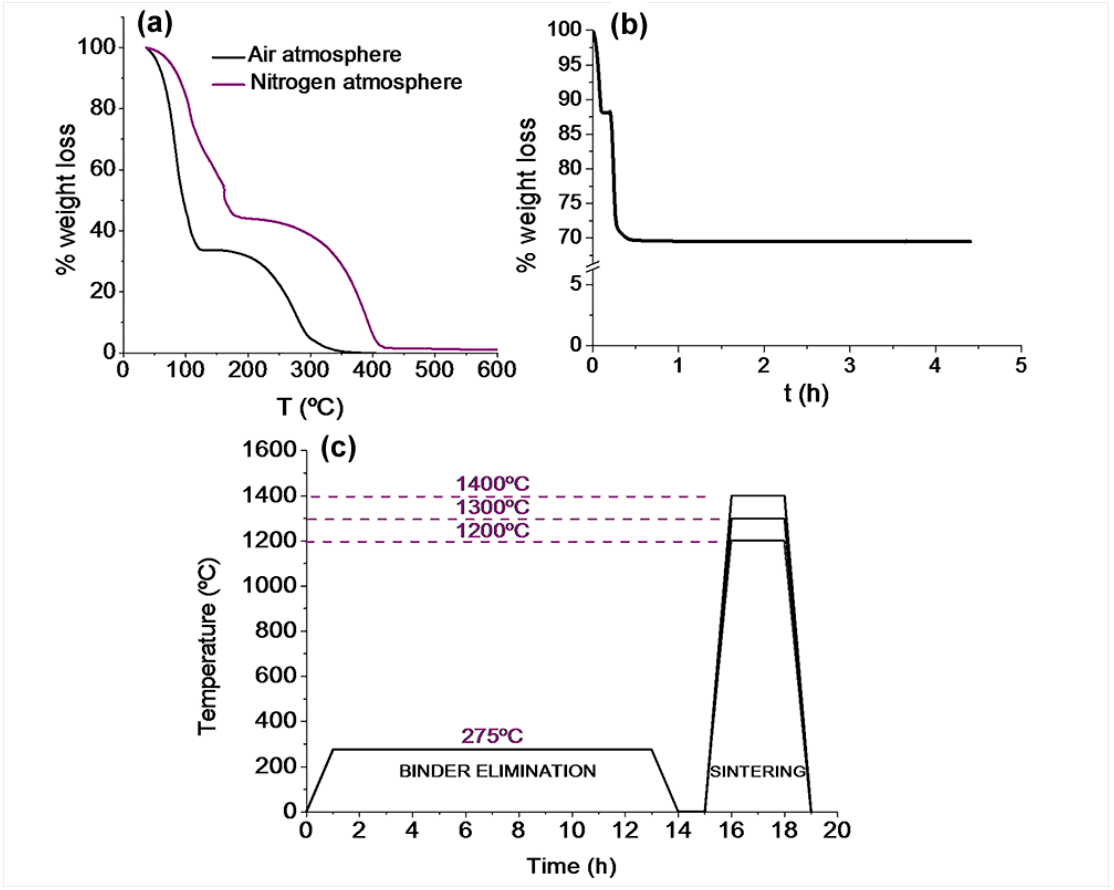
Figure 3. Thermogravimetric analysis: ( a ) Dynamic TGA of the binder, Pluronic F-127, and ( b ) isothermal TGA of the ink at 275 °C. ( c ) Heat treatment profile: scaffolds are first introduced in an oven under air atmosphere to eliminate the binder and then sintered in a tubular furnace under Ar atmosphere.